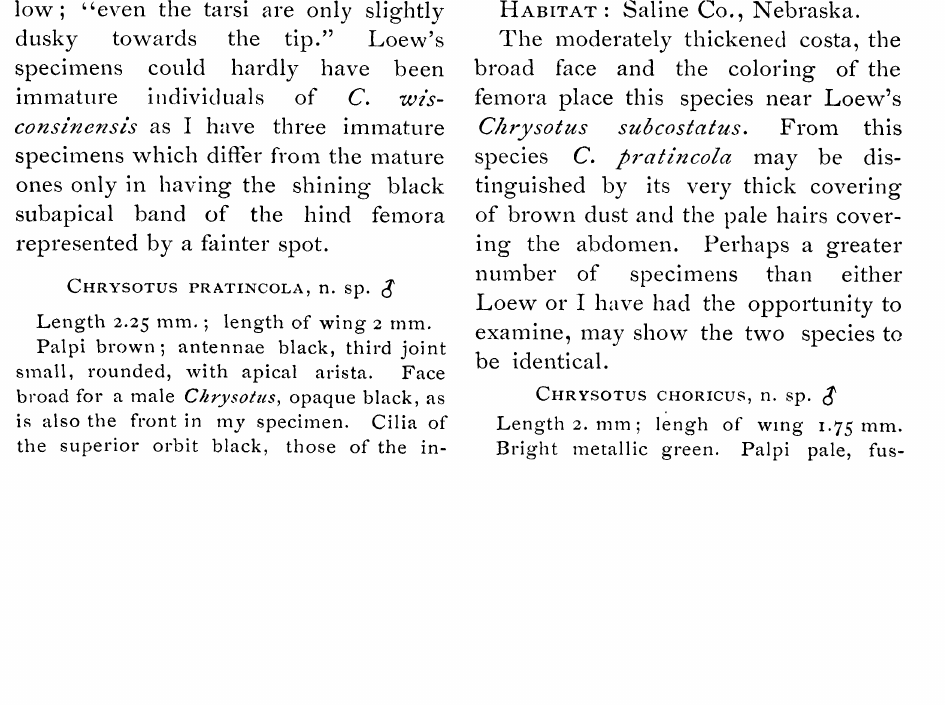
hairs covering the abdomen dirty white. Hy- popygium black, concealed; venter of a paler and more bluish metallic green than the terga. Coxae opaque black, tipped with yellow and each provided with a tuff of glistening white hairs on the anterior face; these hairs are longest on the fore coxae. Legs not very hairy; femora black with metallic green lustre, especially on the hind pair; their apices and extreme bases yellow; tibiae yellow covered with short weak black hairs; tarsi yellow, blackened on all the feet from the tip of the first joint; hind tarsi scarcely as long as the hind tibiae. Hal- teres honey yellow. Wings hyaline, with very faint grayish tinge; veins black; the black costa is moderately incrassated from its juncture with the first it gradually diminishes in thickness; pos- terior cross-vein in front of the middle of the